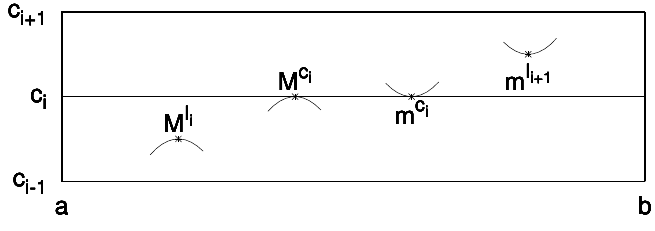
Fig. 1 Four bad symbols with respect to the critical line y = c i . The rest are of the form M I j , M c k with j , k < i , and m I j , m c k with j , k > i